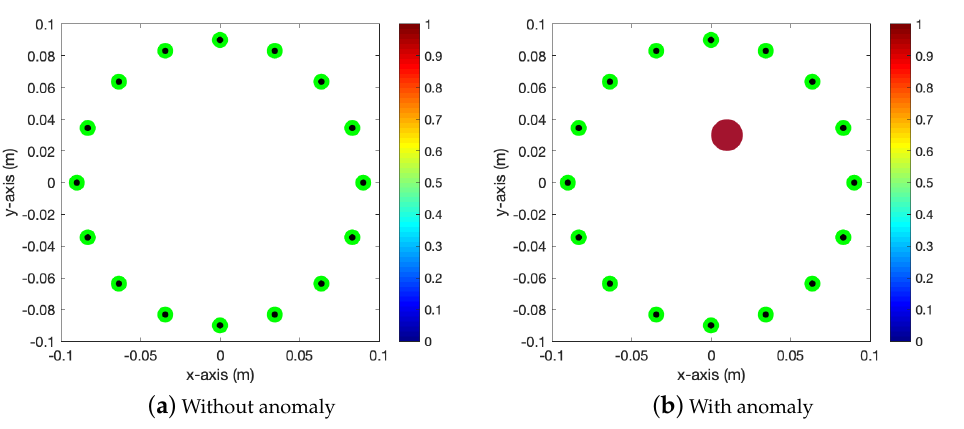
Figure 1. Illustration of the simulation